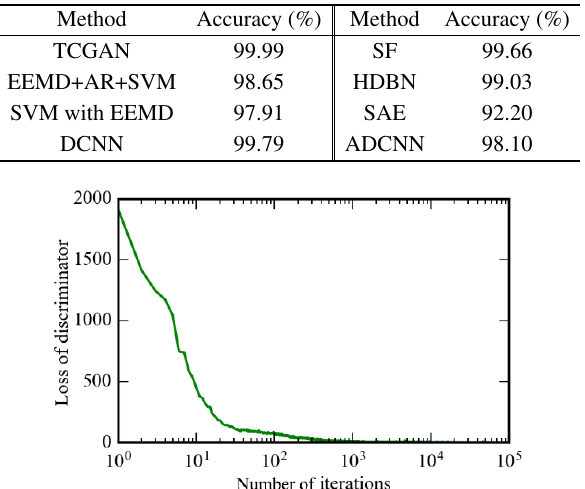
Fig. 8 Loss of discriminator with 2000 samples in Case 1.